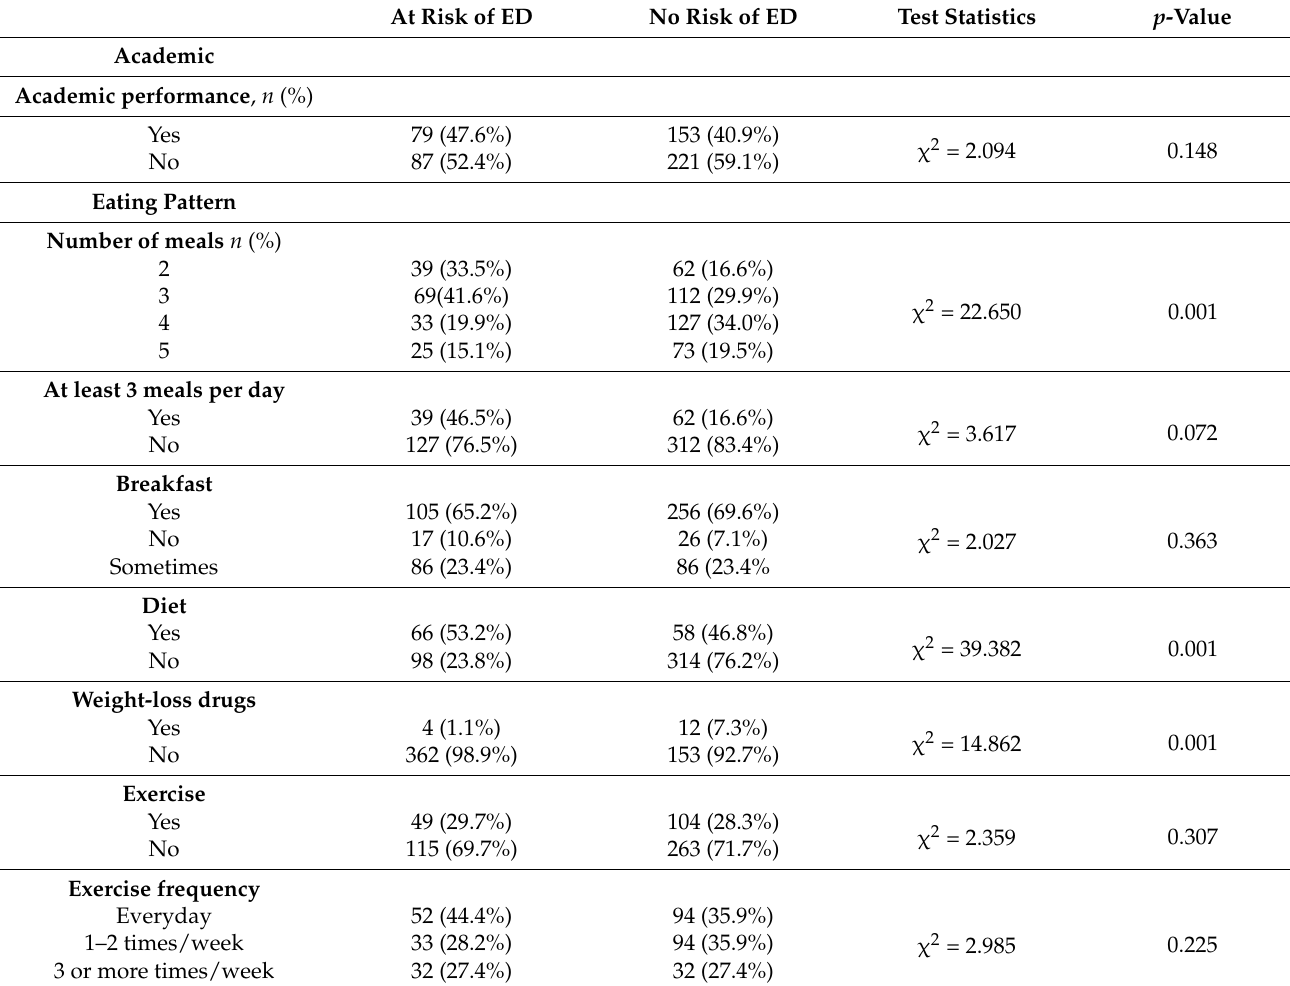
Table 3. Distribution of variables related to eating patterns and weight loss measures according to eating disorder risk.